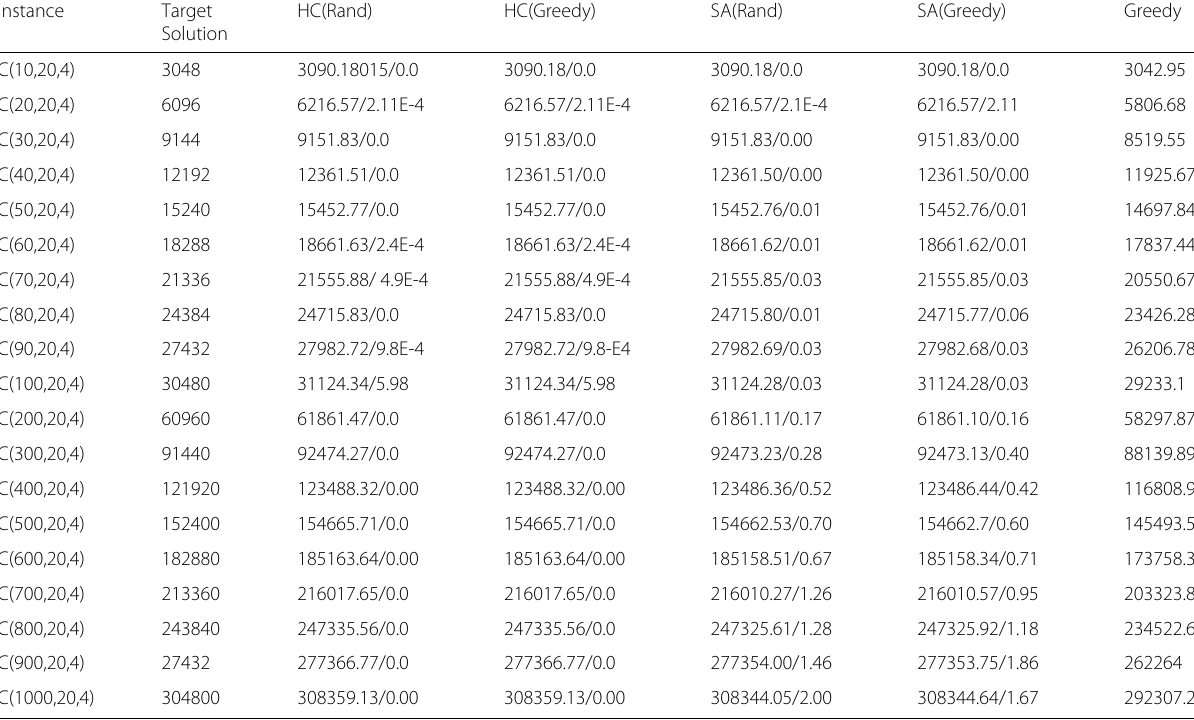
Table 6 Optimal values and standard deviation of different